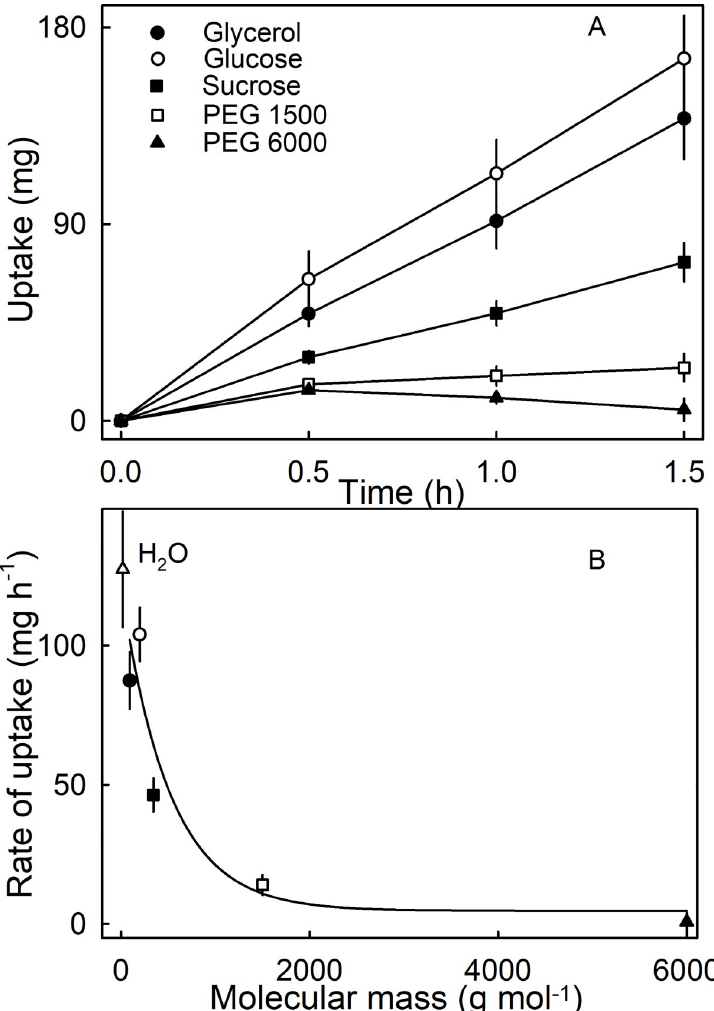
Fig 8. Effect of different molecular mass of isotonic solutions on osmotic uptake. (A) Cumulative uptake. (B) Rates of uptake. (Bars represent SE).